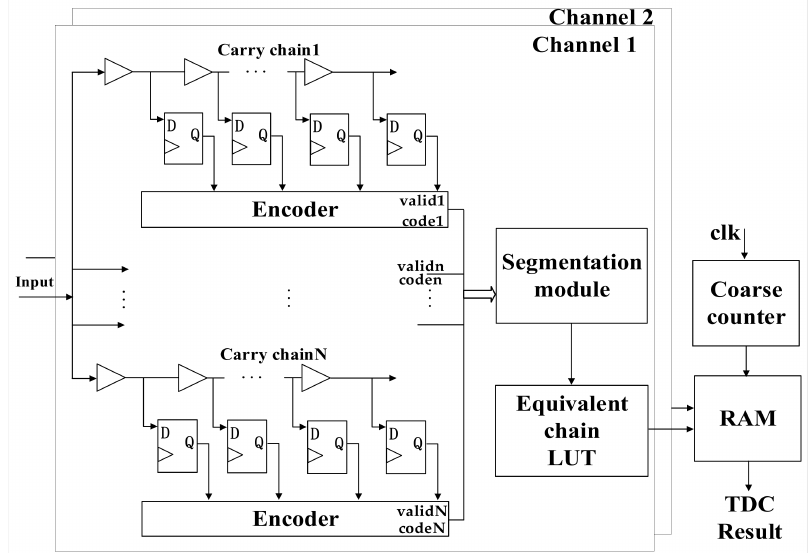
Figure 6. Block diagram of 2-channel TDC based on the multichain cross